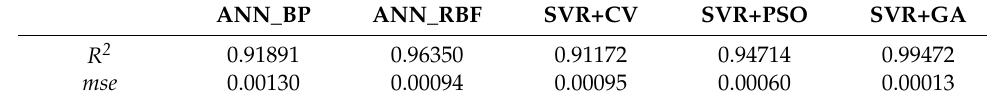
Table 4. The statistical performance comparison of test results for T V e / 20 V e .